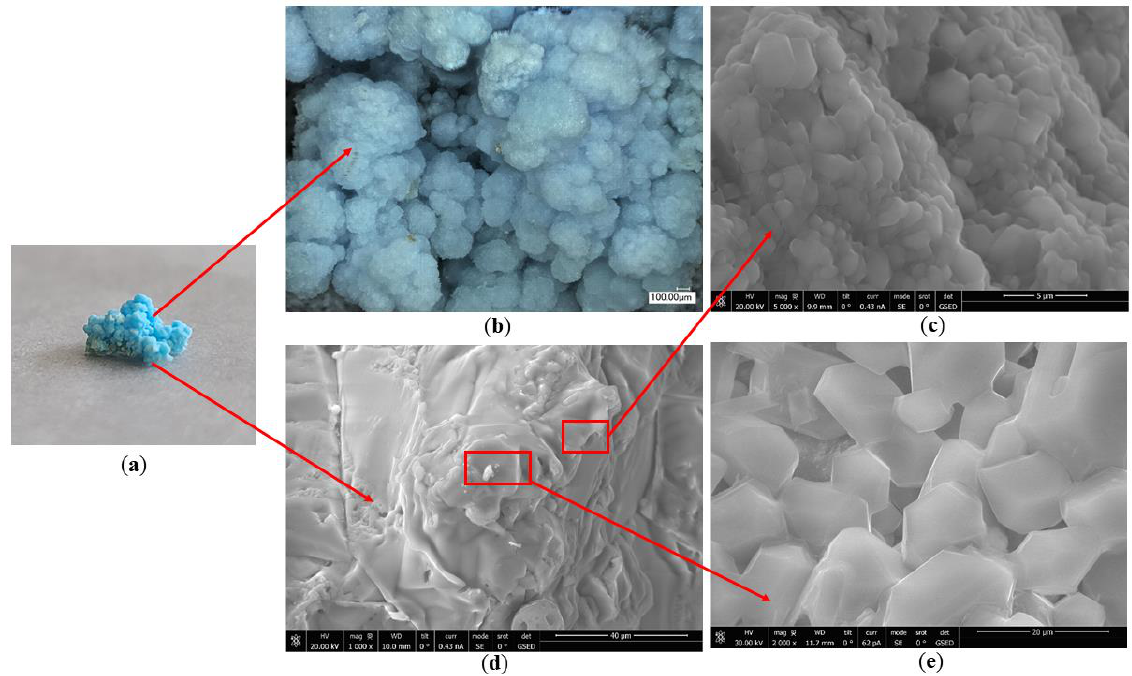
Figure 7. Photos of clustered salt crystals ( a ) crystals collected from the salt belt; ( b ) clustered crystals ( c ) top of clustered crystals; ( d ) side of clustered crystals; ( e ) micro-morphology of the crystals.